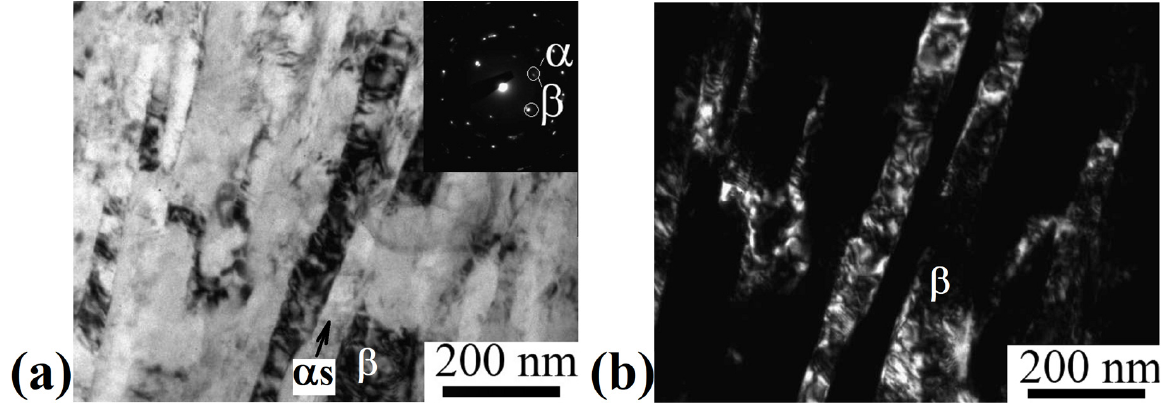
Figure 8. Microstructure of the Ti-15Mo alloy after ECAP-C, drawing and annealing to relieve internal stresses, longitudinal section: ( a ) bright-field image; ( b ) dark-field image of β -phase grains.